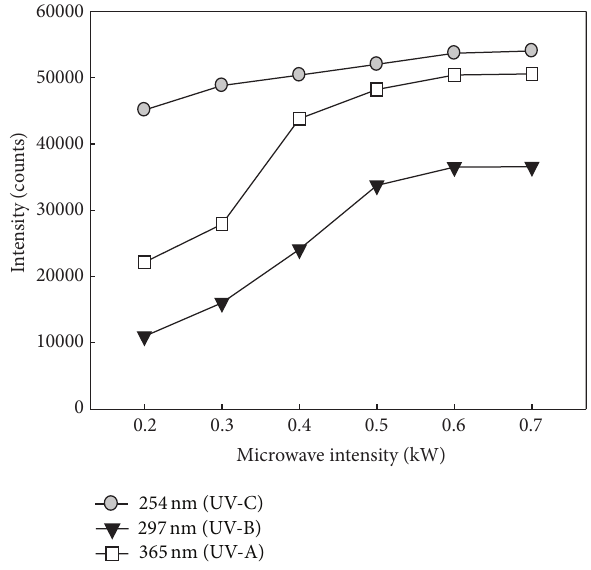
Figure 2: Change of the UV intensities radiated at different microwave intensities.